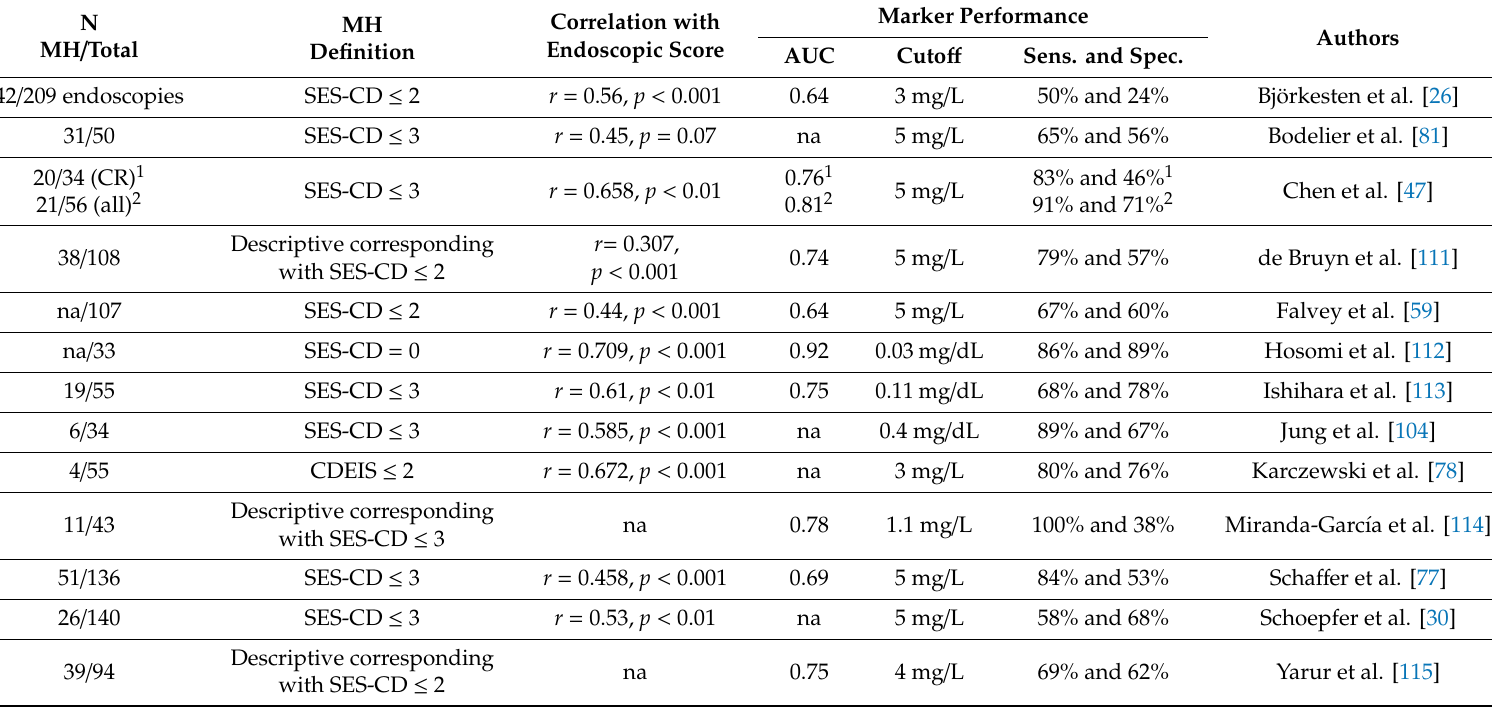
Table 7. Diagnostic performance of C-reactive protein in MH detection for Crohn’s